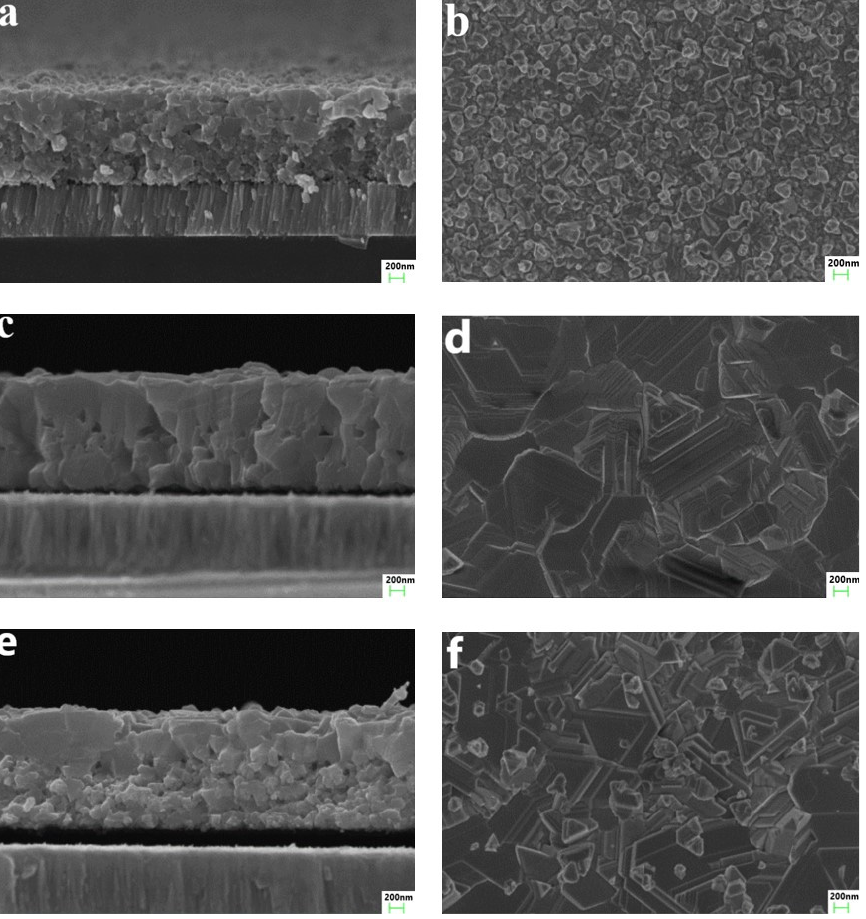
Figure 2. SEM images of annealed layers. ( a ) Cross-section morphology of structure 1, ( b ) surface morphology of structure 1, ( c ) cross-section morphology of structure 2, ( d ) surface morphology of structure 2, ( e ) cross-section morphology of structure 3, ( f ) surface morphology of structure 3.